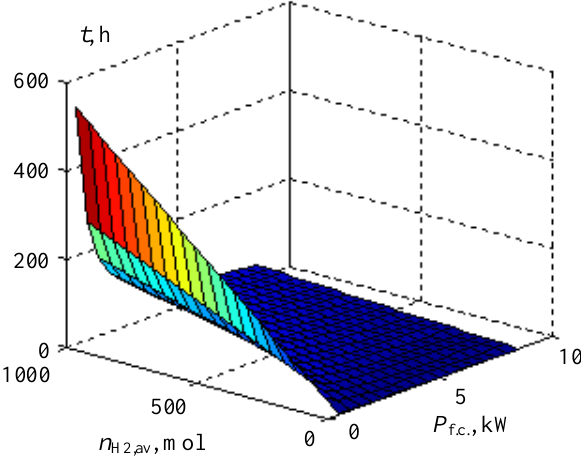
Fig. 7. Possible usage time in hours of the stored hydrogen depending on the used power of the fuel cell and the available hydrogen amount.